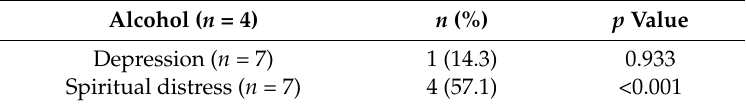
Table 7. Alcoholic liver disease related to depression and spiritual